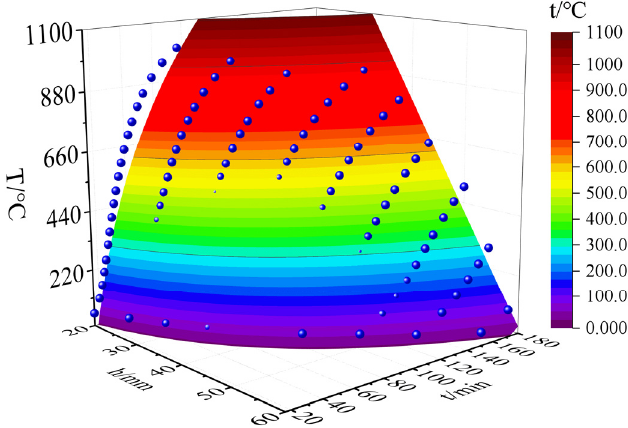
Figure 25. Surface fitting results of high ‐ silica needled felt.